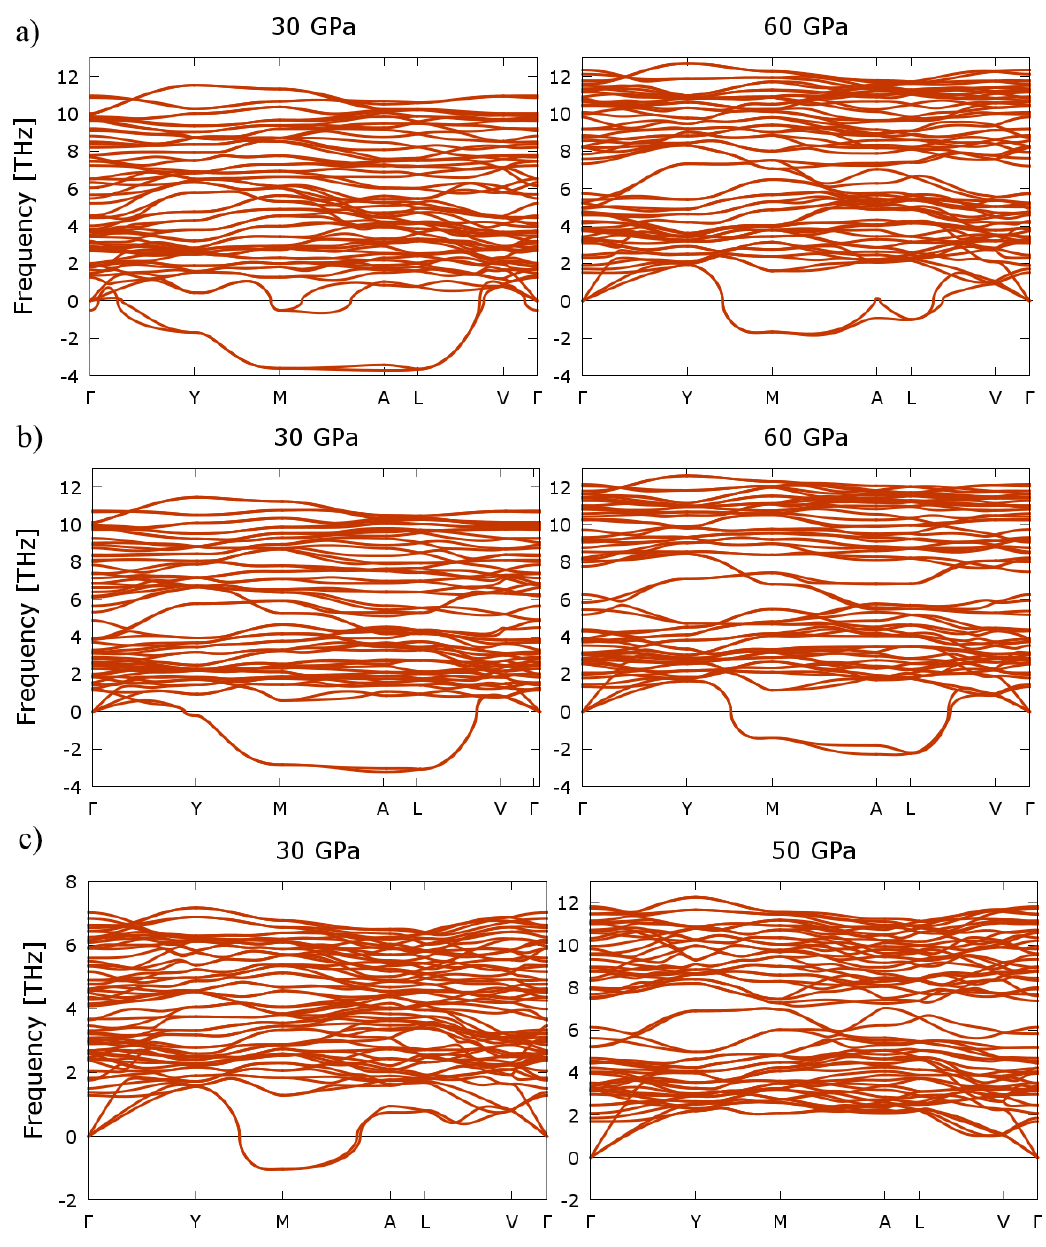
Figure 4. Harmonic phonon dispersion curves of the disordered bcc-like Im-3m phases of Sb 2 S 3 ( a ), Bi 2 S 3 ( b ), and Sb 2 Se 3 ( c ); and calculated at 30 GPa ( left ), and 50 (Sb 2 Se 3 ) or 60 GPa (Sb 2 S 3 and Bi 2 S 3 ; right ). The BZ q − vector description represents the C2/m space − group, according to the symmetry of the employed